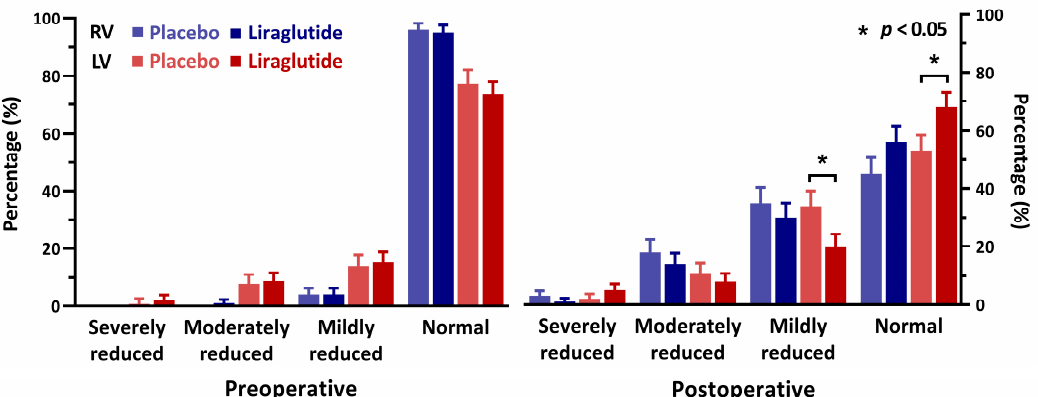
Figure 1. Echocardiographic assessment of cardiac function before and after surgery, percentage of patients. RV = right ventricle, LV = left ventricle.